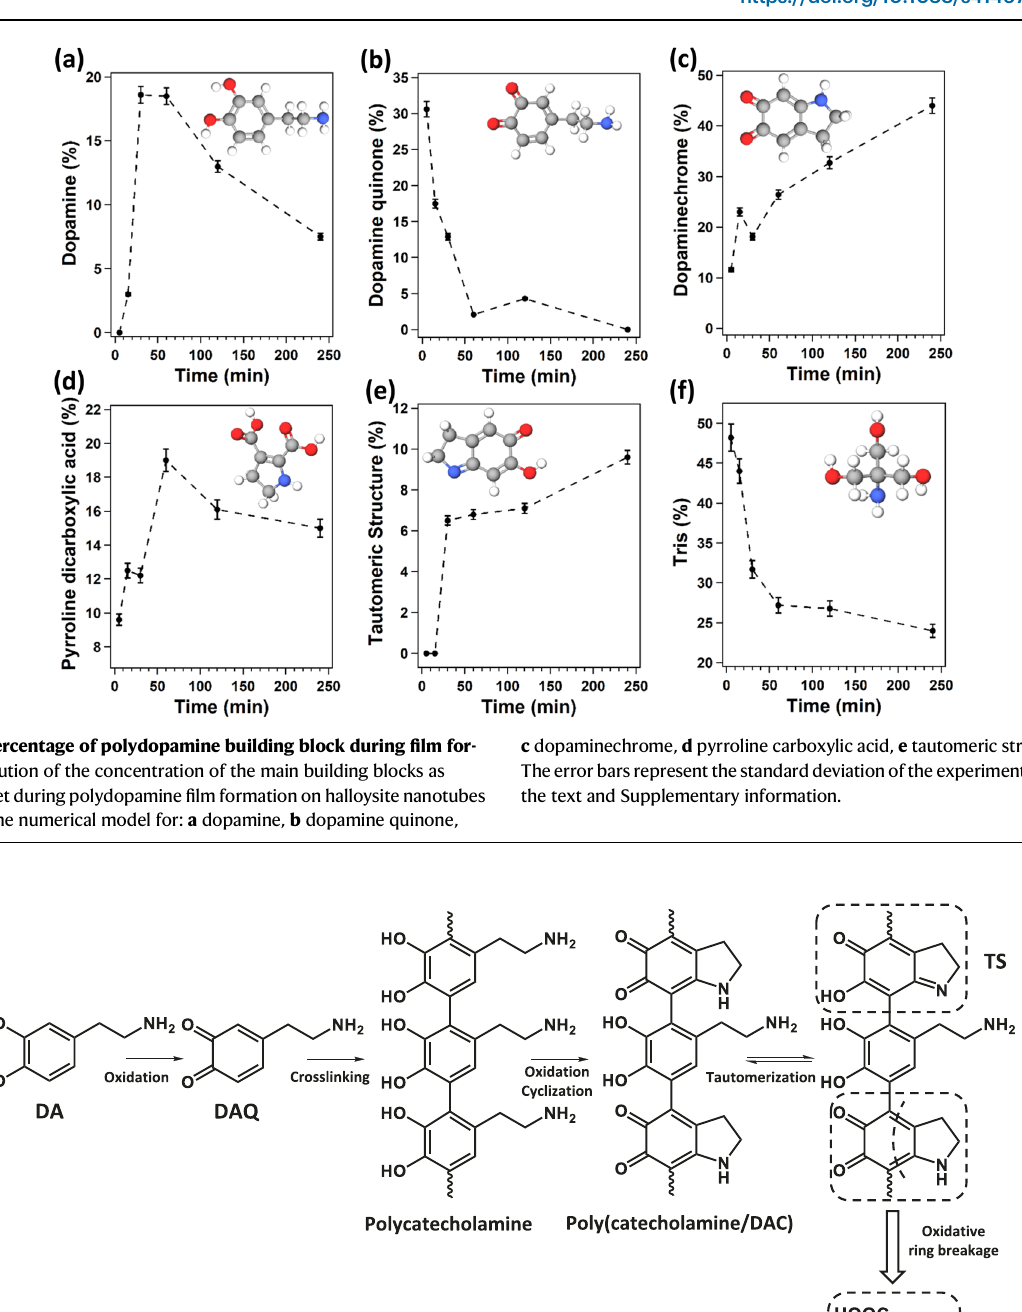
Fig. 9 | Polydopamine fi lm formation. Proposed model for polydopamine fi lm formation.